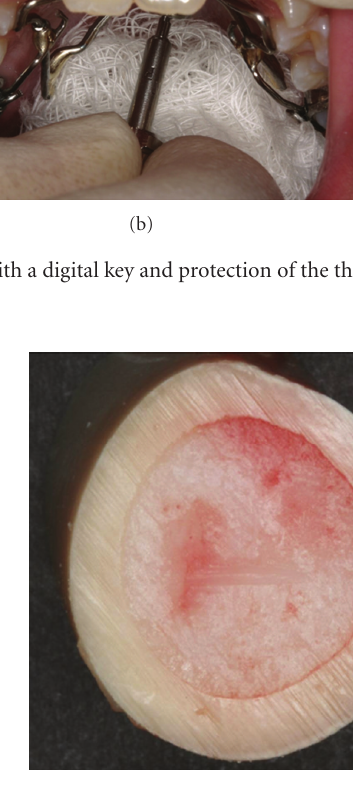
Figure 6: Di ff erent directions for OI installation. (a) Length of bone contact with OI inserted perpendicular to the cortical bone and (b) length of bone contact with OI inserted tilted with respect to cortical